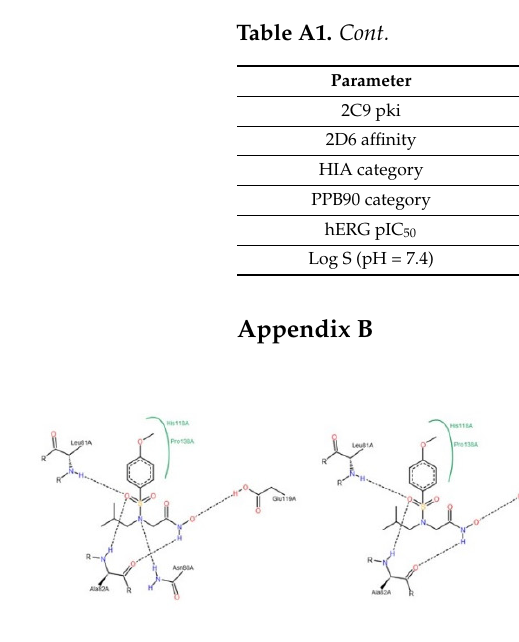
Figure A4. Interactions between NNGH inhibitor and MMP-9, by PoseView calculations.